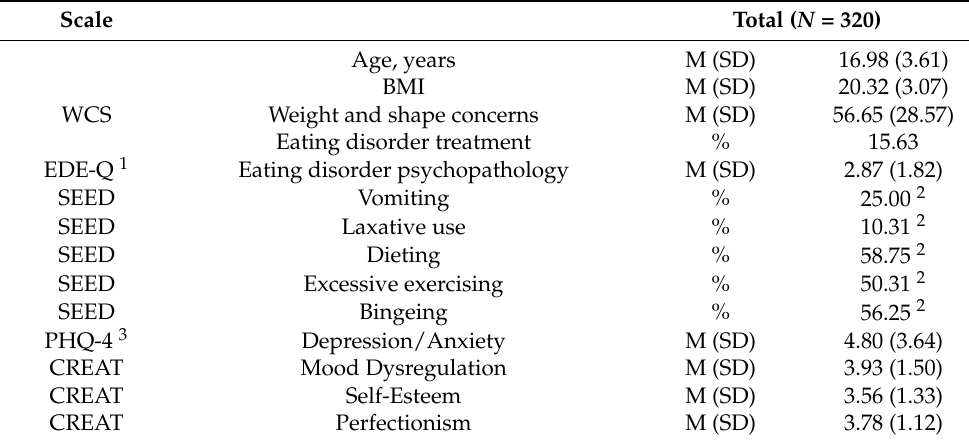
Table 1. Sample characteristics.